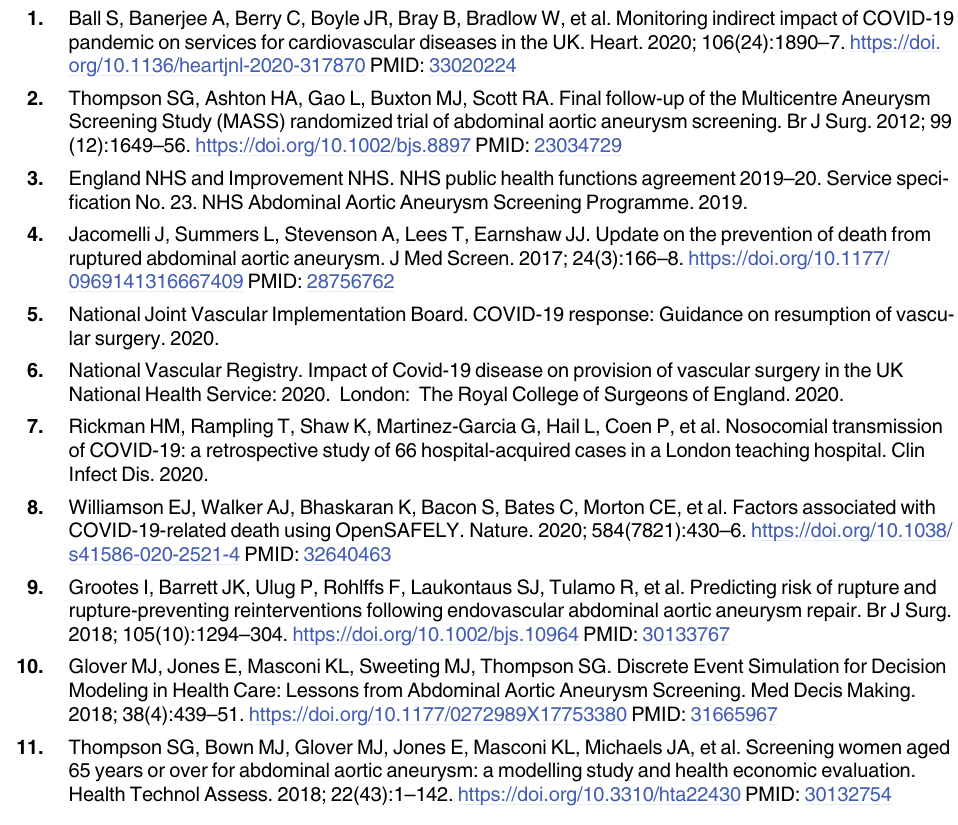
S2 Fig. Convergence in the status quo model in the surveillance cohort. Cumulative propor- tions for iteration numbers 100,000 to 10m: (a) AAA deaths, (b) ruptures, (c) elective opera- tions. (TIF) S3 Fig. Cumulative impact of scenarios on surveillance cohort. S1 = surveillance scan sus- pension; S2.1 = 10% dropout/annum for 1 year; S2.2 = 10% dropout/annum for 2 years; S3 = 7cm threshold for 2 years before reverting to 5.5cm.